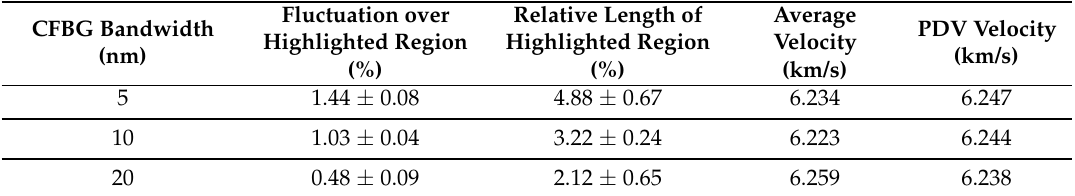
Table 2. The properties of the non-linear region for different bandwidth (5 nm, 10 nm, and 20 nm) CFBG tests, with reflectivities in the range 59–68%.